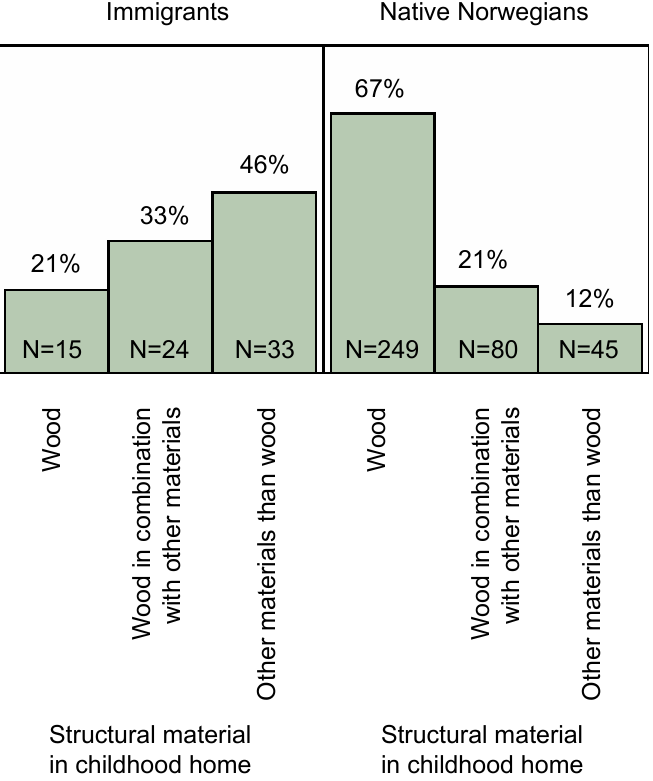
Figure 1. Distributions in N (number) and % of what kind of houses with respect to the structural material that the immigrants and the native Norwegians respectively had lived in the most until they were 16 years old. Table 1. Statistics for the